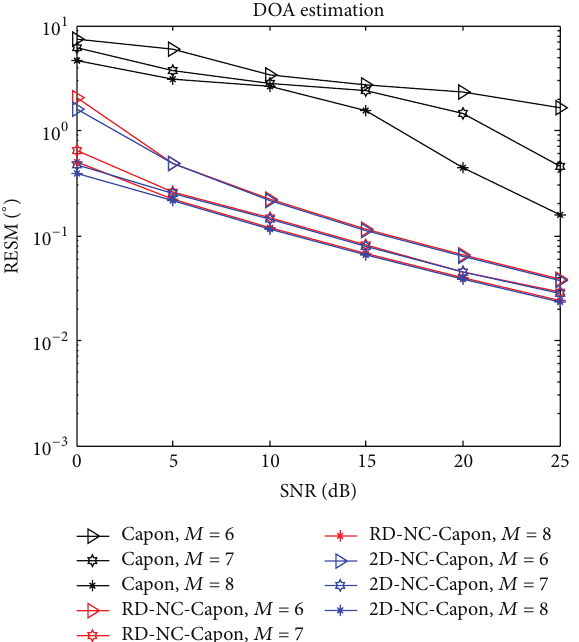
Figure 8: The DOA estimation performance with different numbers of antennas ( 𝐿 = 200 and 𝐾 = 3 ).